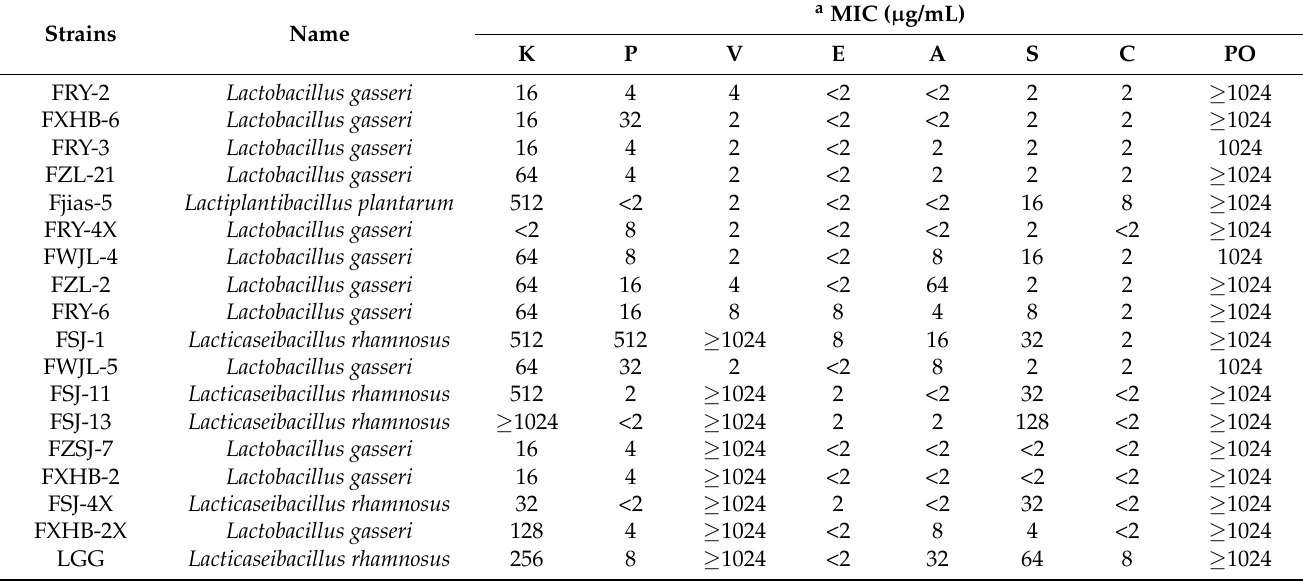
Table 3. Antibiotic resistance of tested